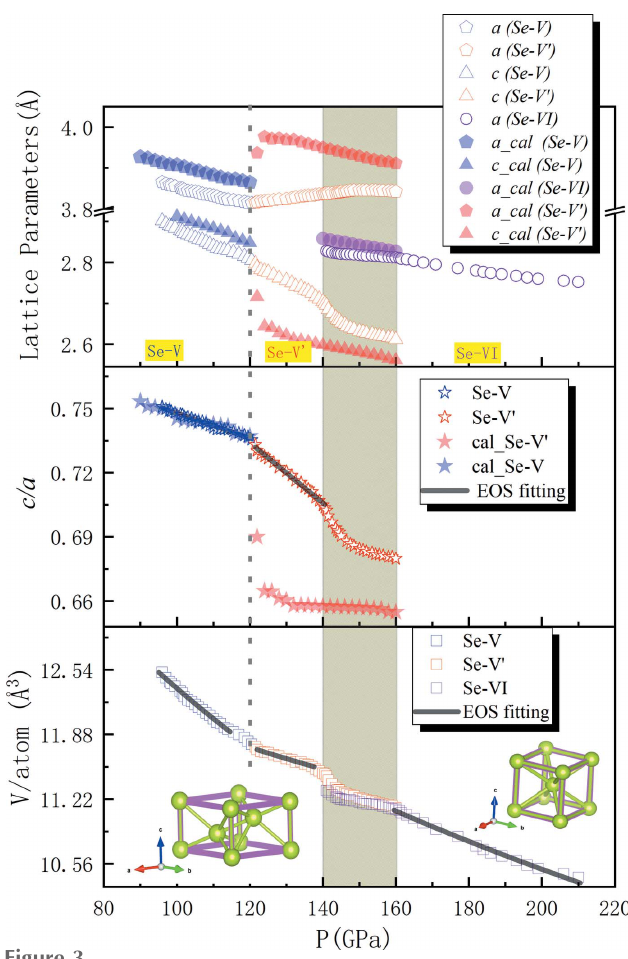
Figure 3 Pressure dependence of lattice parameters a and c , and atomic volume V from 90 to 210 GPa. The open symbols represent experimental data in this work, the solid symbols represent the calculated lattice constants a and c , and the c / a ratio, respectively. The b.c.c. structure remains stable up to 210 GPa, no new phase transition was observed from 140 to 210 GPa. The phases Se-V 0 and Se-VI coexist from 140 to 160 GPa.